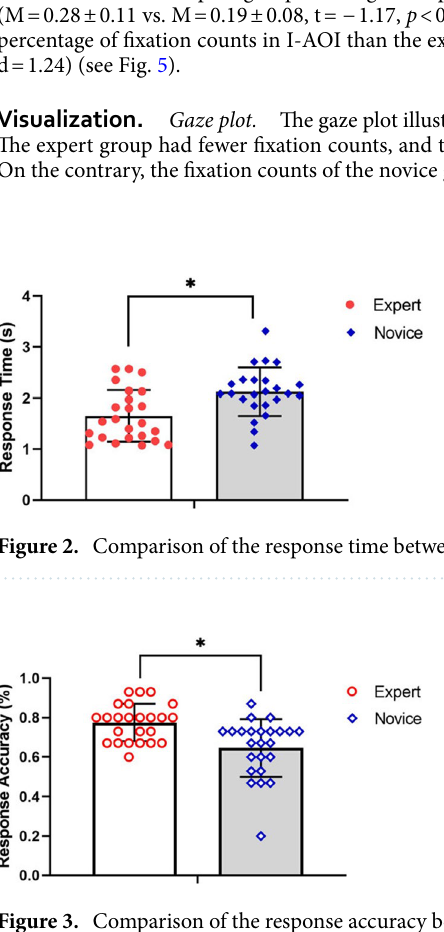
Figure 3. Comparison of the response accuracy between